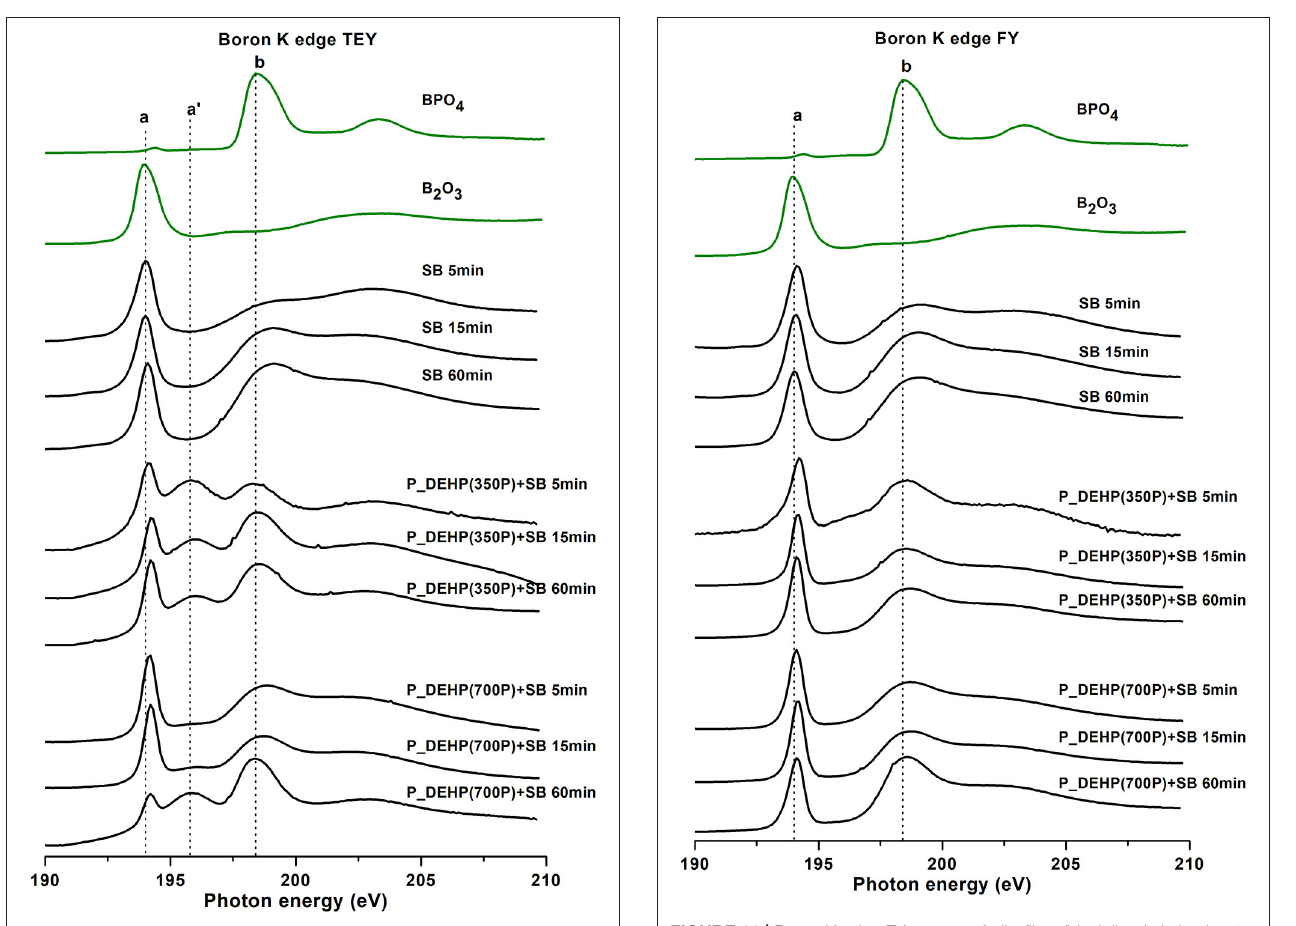
FIGURE 11 | Boron K-edge FY spectra of tribofilms (black lines) derived at 5, 15, and 60min test for SB, P_DEHP(350P) + SB, and P_DEHP(700P) + SB lubrication along with model compounds (green